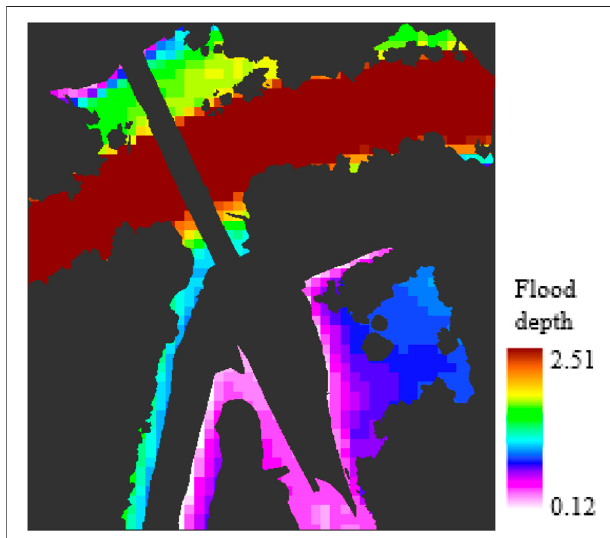
FIGURE9| DepthresultsforGFIinthedeeplearning-based fl oodextent (Unit: meter).